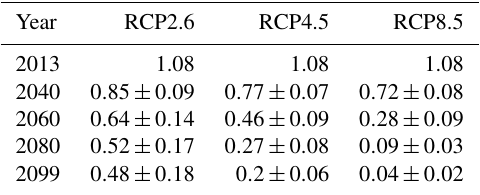
Table 3. Projected maximum ice thickness in metres for different scenarios and years: mean and standard deviation obtained by forc- ing SICOPOLIS for 23 climate